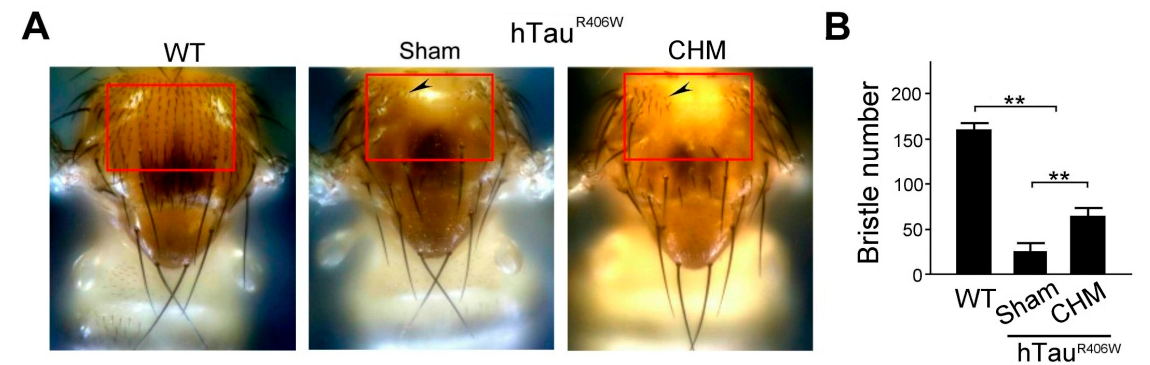
Figure 4. Chinese herbal medicine treatment showed favorable therapeutic effects for tauopathy alleviation by notal bristle quantification: ( A ) Numbers of notal bristle (as indicated by arrows) within the red frames of the hTau R406W flies with sham and Chinese herbal medicine (CHM) treatments were notably lower than in their WT counterparts; hTau R406W flies under CHM treatments demonstrated higher notal bristle numbers than the hTau R406W flies under sham treatment. ( B ) Quantified comparison of the number of notal bristles among hTau R406W flies under sham and CHM treatments, and their WT counterparts (sampled number of flies = 30 for each group, three replicate experiments for each group). Values are mean ± SEM (** p < 0.01, two-way ANOVA followed by Mann – Whitney non-parametric test for comparisons).